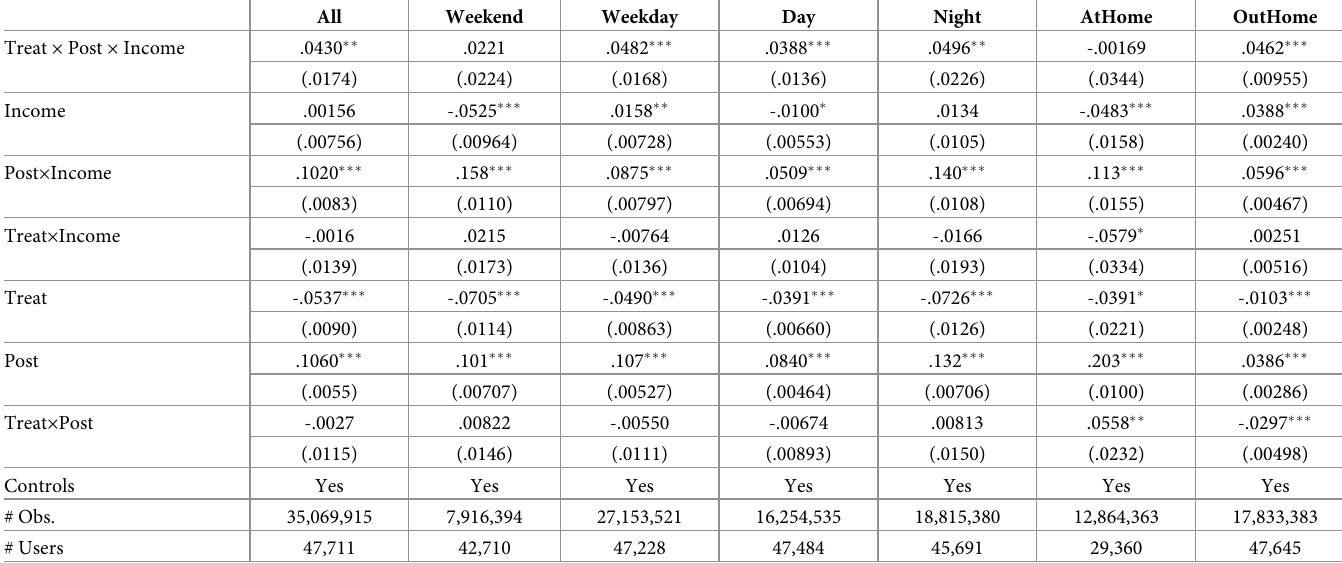
Table 4. Socioeconomic divergence in the shift in family